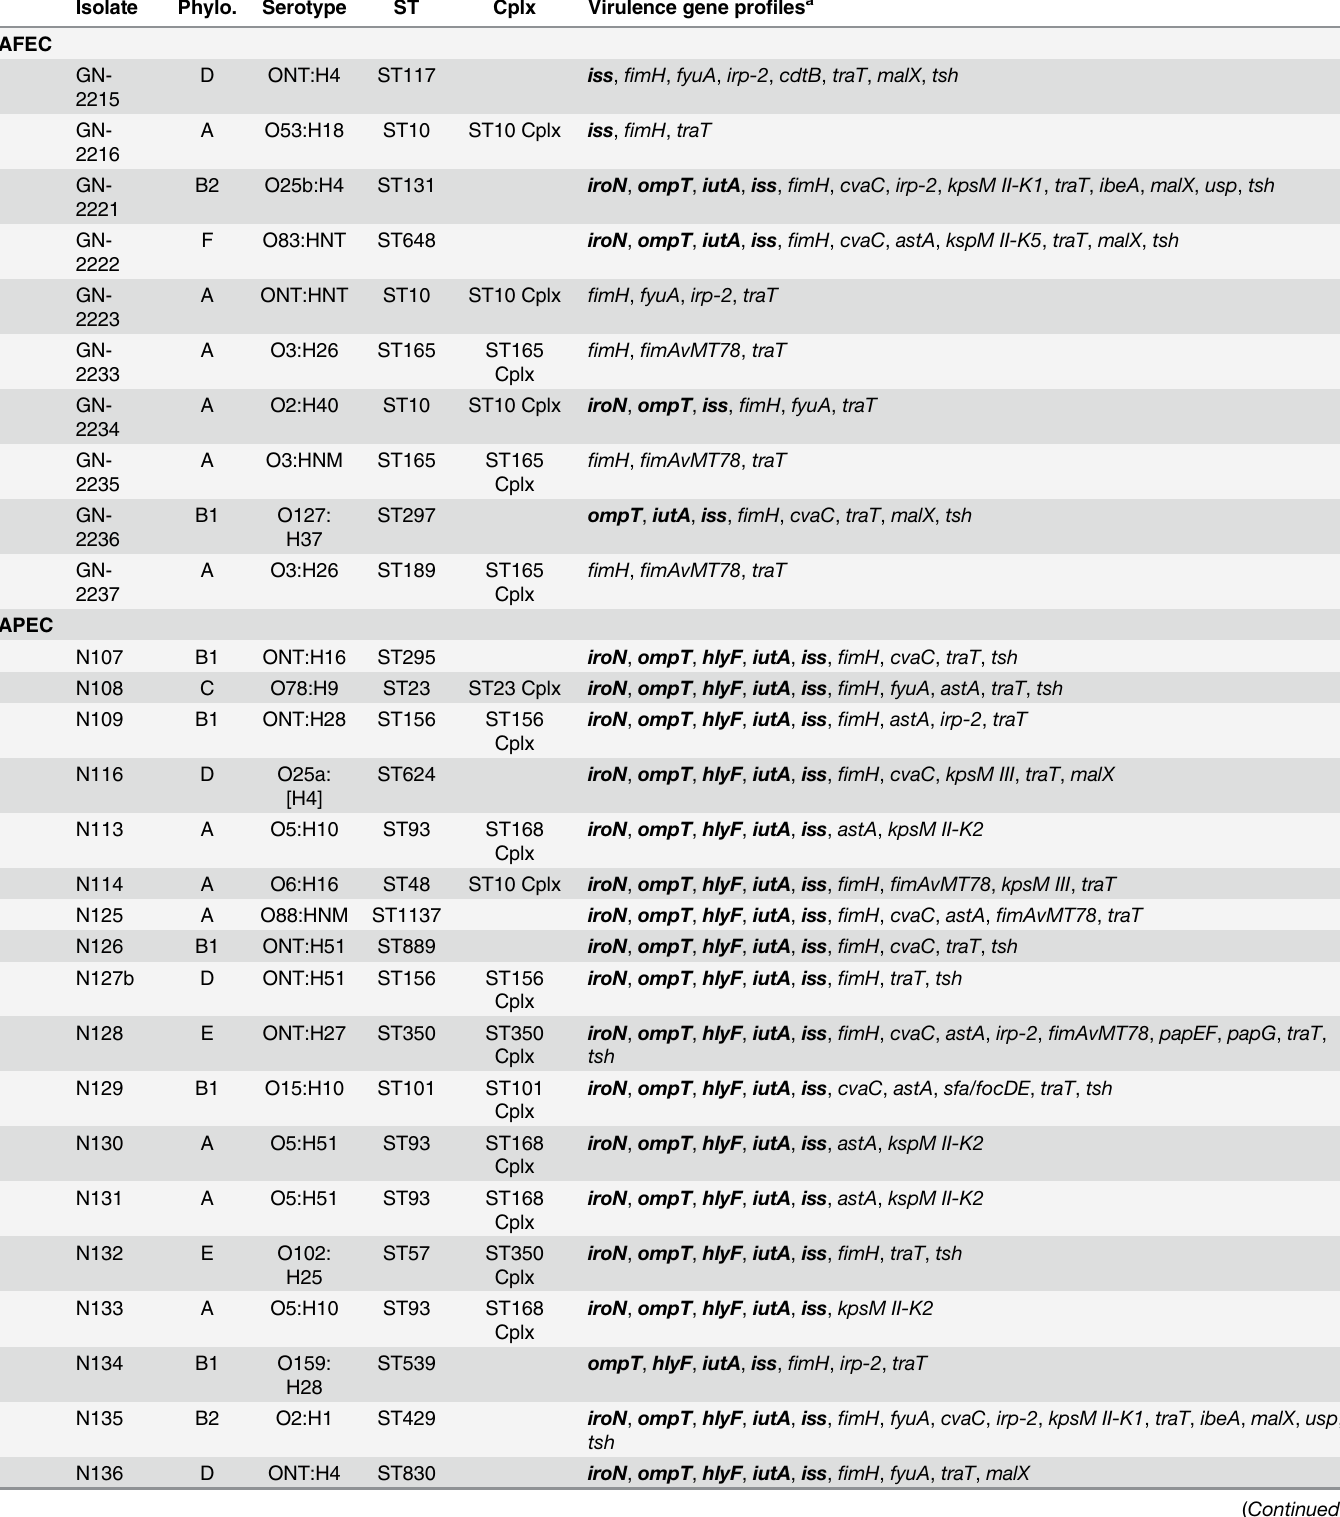
Table 1. Distribution of virulence-associated gene profiles, phylogeny, serotyping and MLST results among all 32 strains. Isolate Phylo. Serotype ST